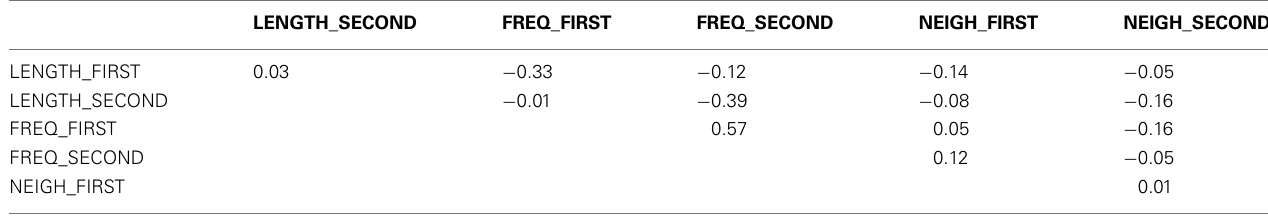
TableA1 | Correlation matrix of predictors utilized in all stimuli analysis before residualization (values indicate pairwise Pearson correlations).